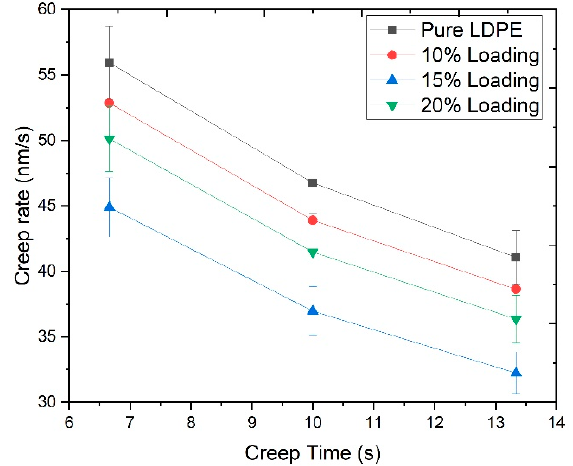
Figure 6. Creep rate vs. holding time of pure LDPE and the biocomposites reinforced with ChCl pretreated RHW loadings (10, 15, and 20 wt.%) at a peak load of 100 mN. pretreated RHW loadings (10, 15, and 20 wt.%) at a peak load of 100